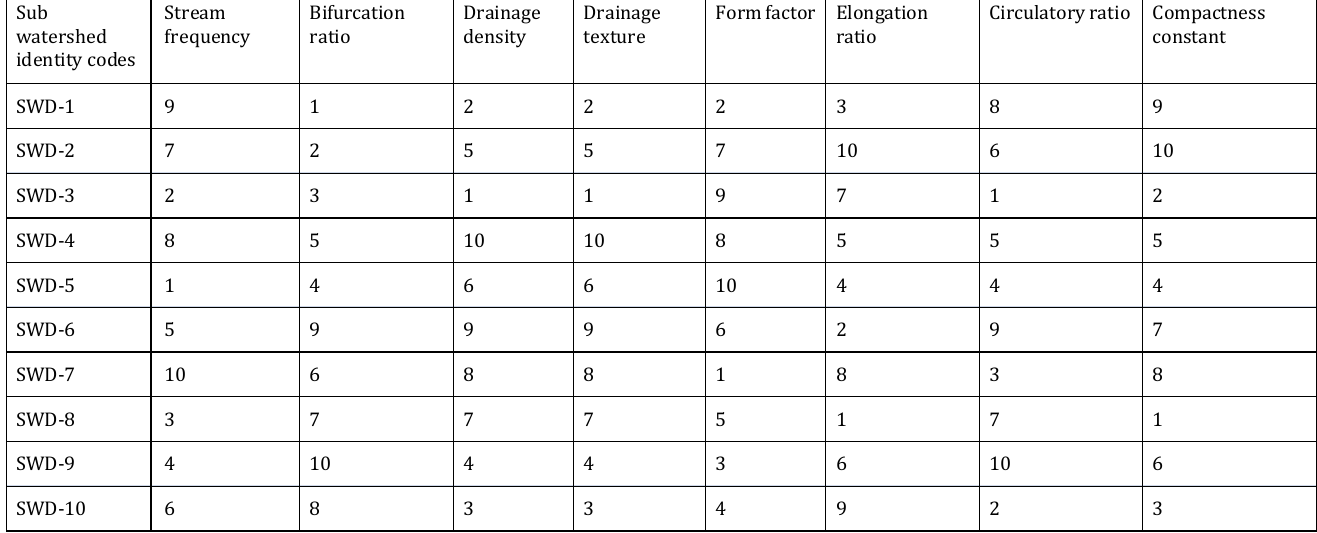
Table 12: Rank allocation to areal aspect of sub watershed of upper watershed of river Subarnarekha